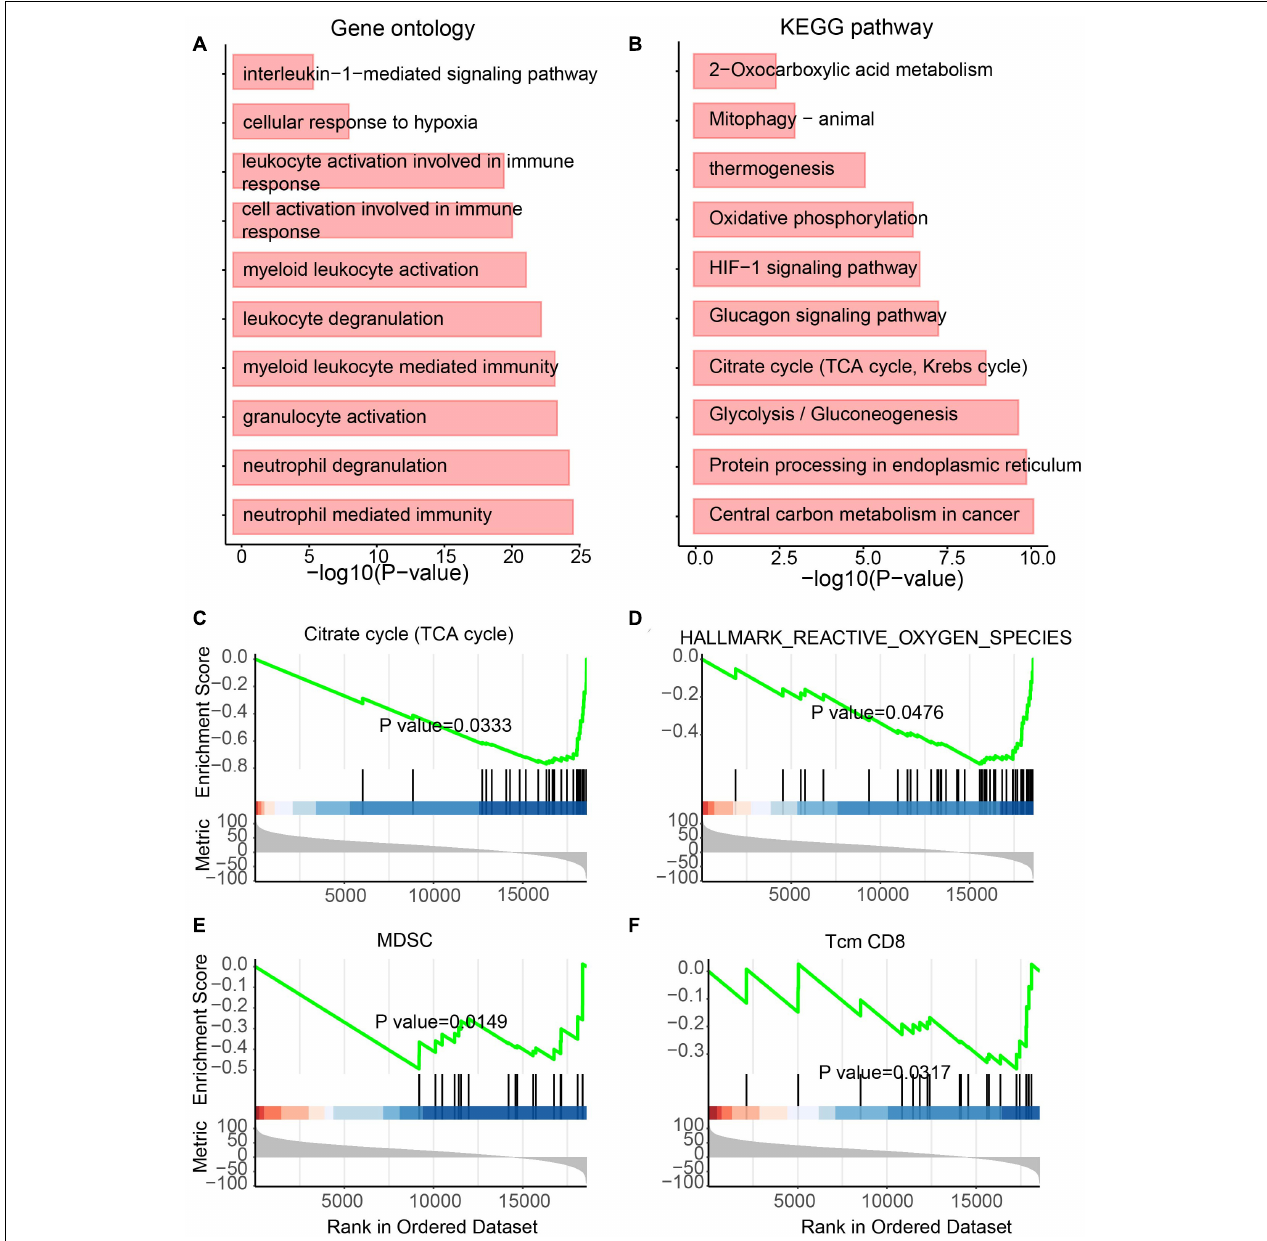
FIGURE 4 | Functional enrichment analysis for differentially expressed lncRNAs. (A) Enriched GO terms. (B) Enriched KEGG pathways. (C–F) Results of GSEA analysis.